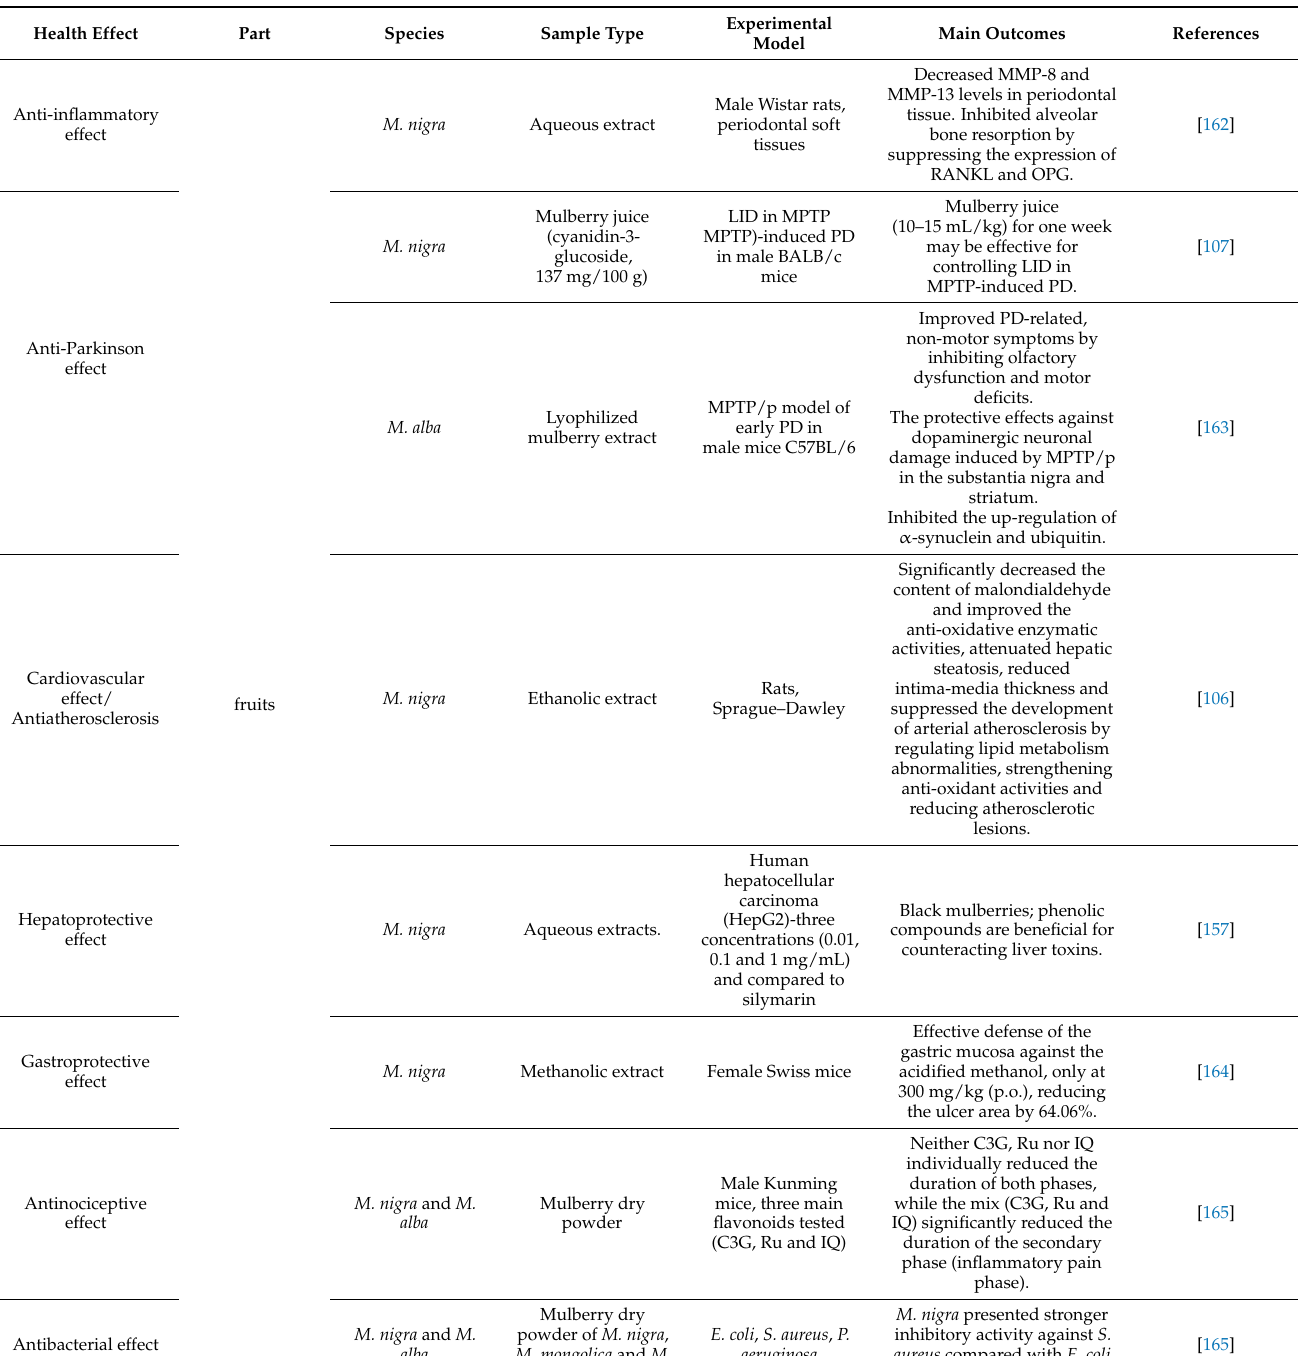
Table 4. The health-promoting properties of different parts of mulberry fruits, as determined in various experimental designs (animal and cell models)